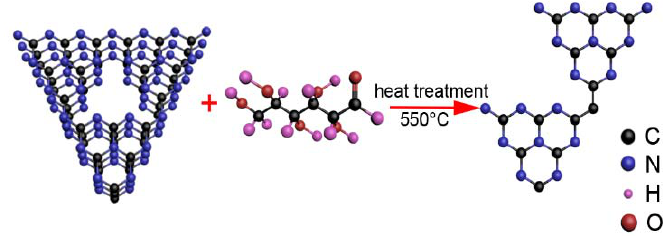
Figure 11. Schematic illustration for the formation of C-C 3 N 4 NS.